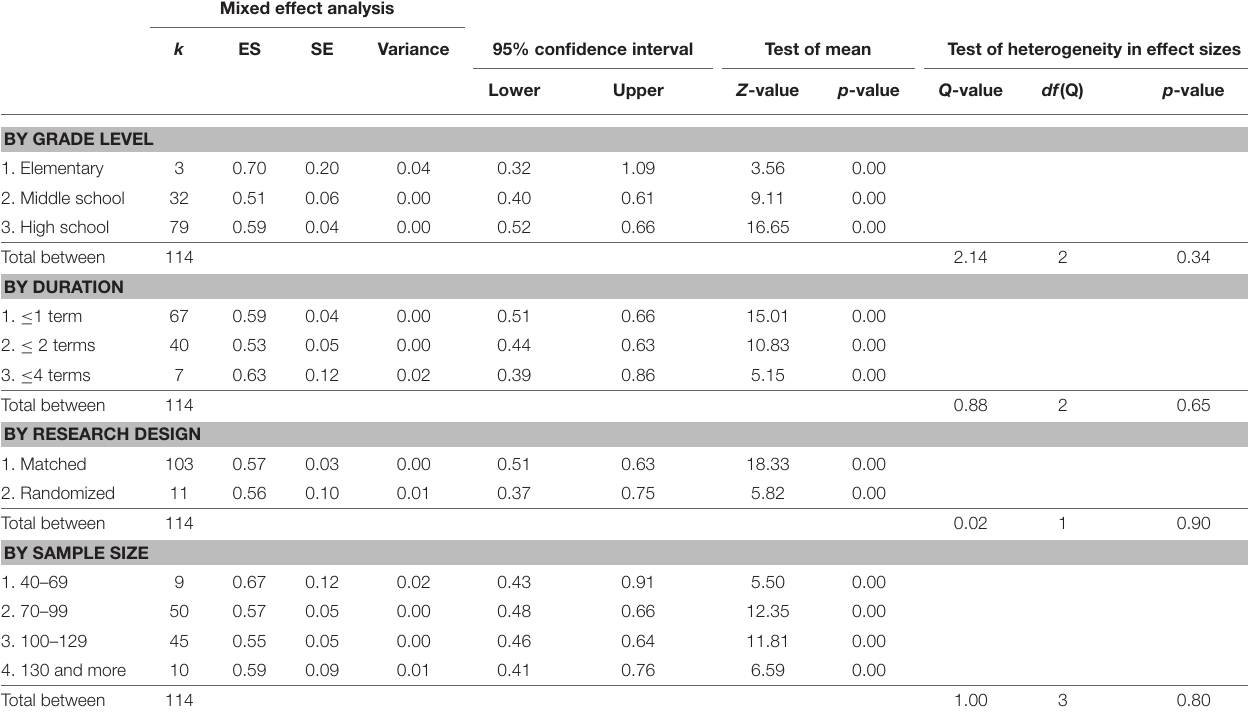
TABLE 7 | Moderator analyses by study